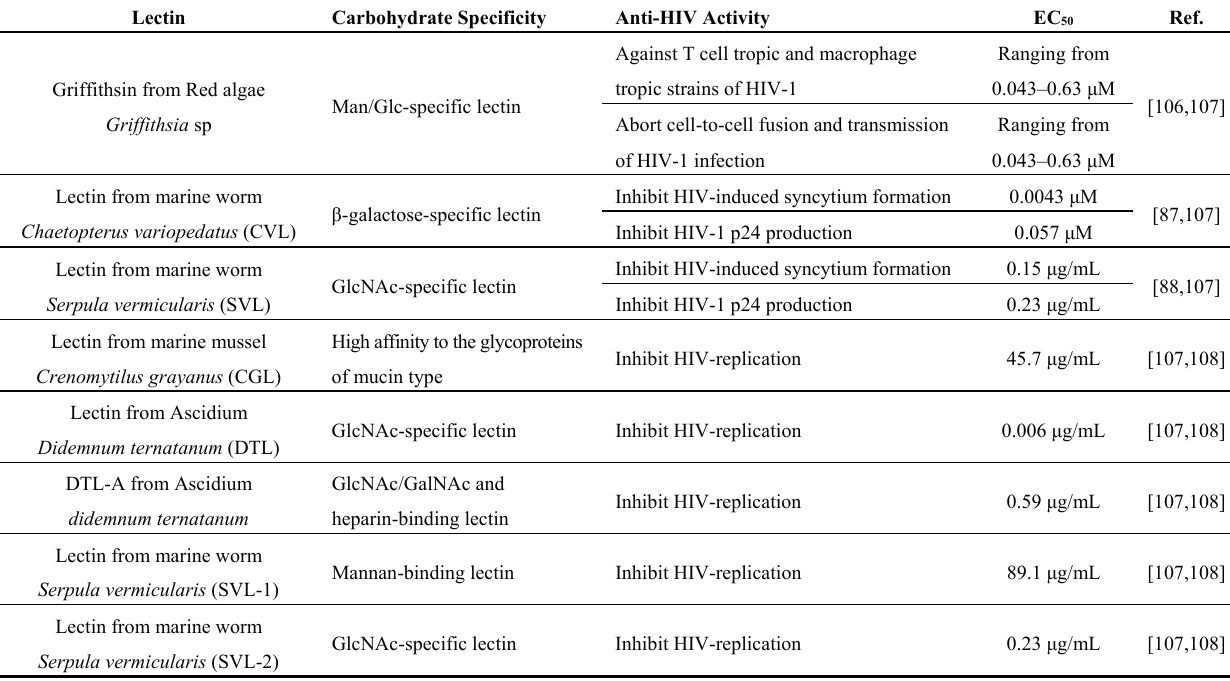
Table 2. Anti-HIV activities of lectins from marine invertebrate animals and a marine